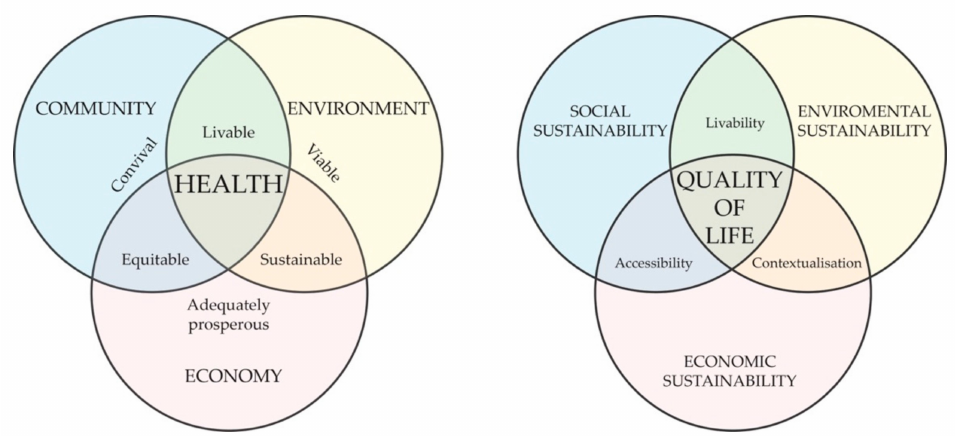
Figure 5. Comparison of the Hancock model (source: Hancock, 1993) [53] (on the left), with the proposed model (on the right) based on the definition of sustainability from the Brundtland Report ( Report of the World Commission on Environment and Development: Our Common Future . Document A/42/427 General Assembly United Nations (UN), New York, USA 1987) [4]. Source: Created by the